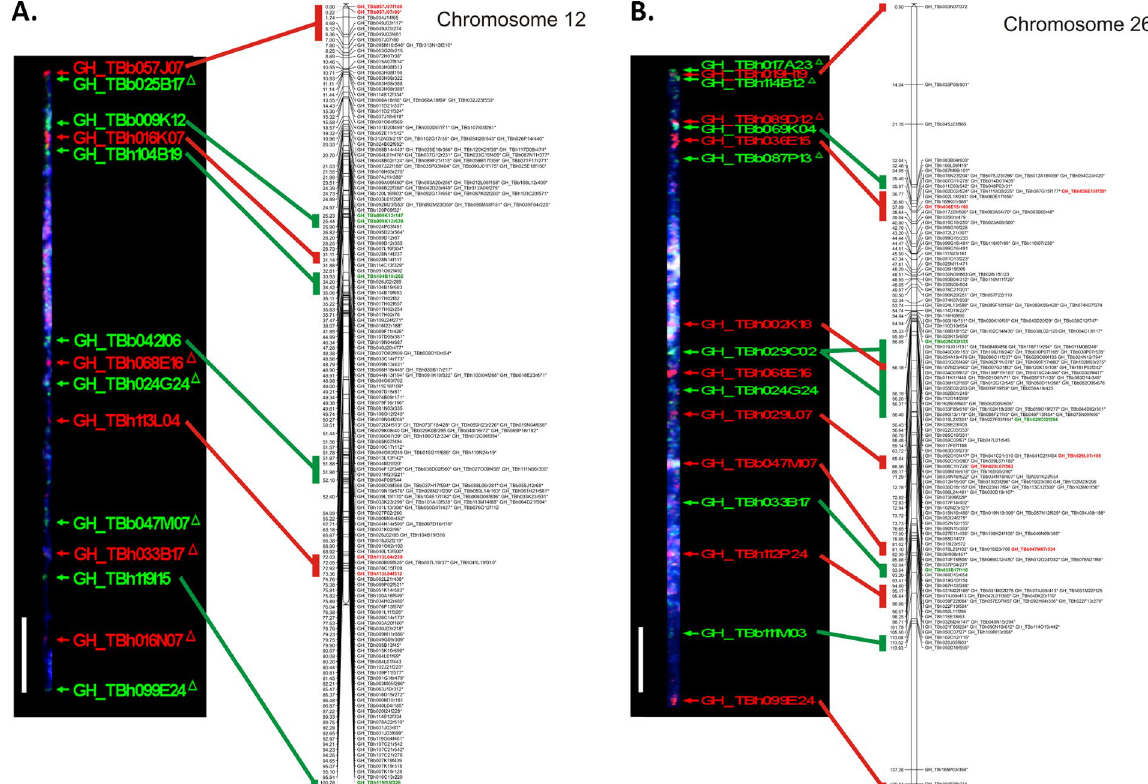
Figure 3. Relative positions of BACs from chromosomes 12 (A12) and 26 (D12) in cytological versus linkage maps. Cytological positions were determined by concomitant FISH of multiple BACs in chromosome-specific multi-BAC probe cocktails to spreads of meiotic pachytene bivalents from Gossypium hirsutum var. TM-1. Images of A12 and D12 bivalents are from two cells. White bars represents 10 µ M. Linkage map positions for SNPs associated with end sequences of BACs in the respective BAC contigs are demarcated by vertical colored bars. ( A ) G. hirsutum bivalent and linkage group for chromosome A12. ( B ) G. hirsutum bivalent and linkage group for chromosome